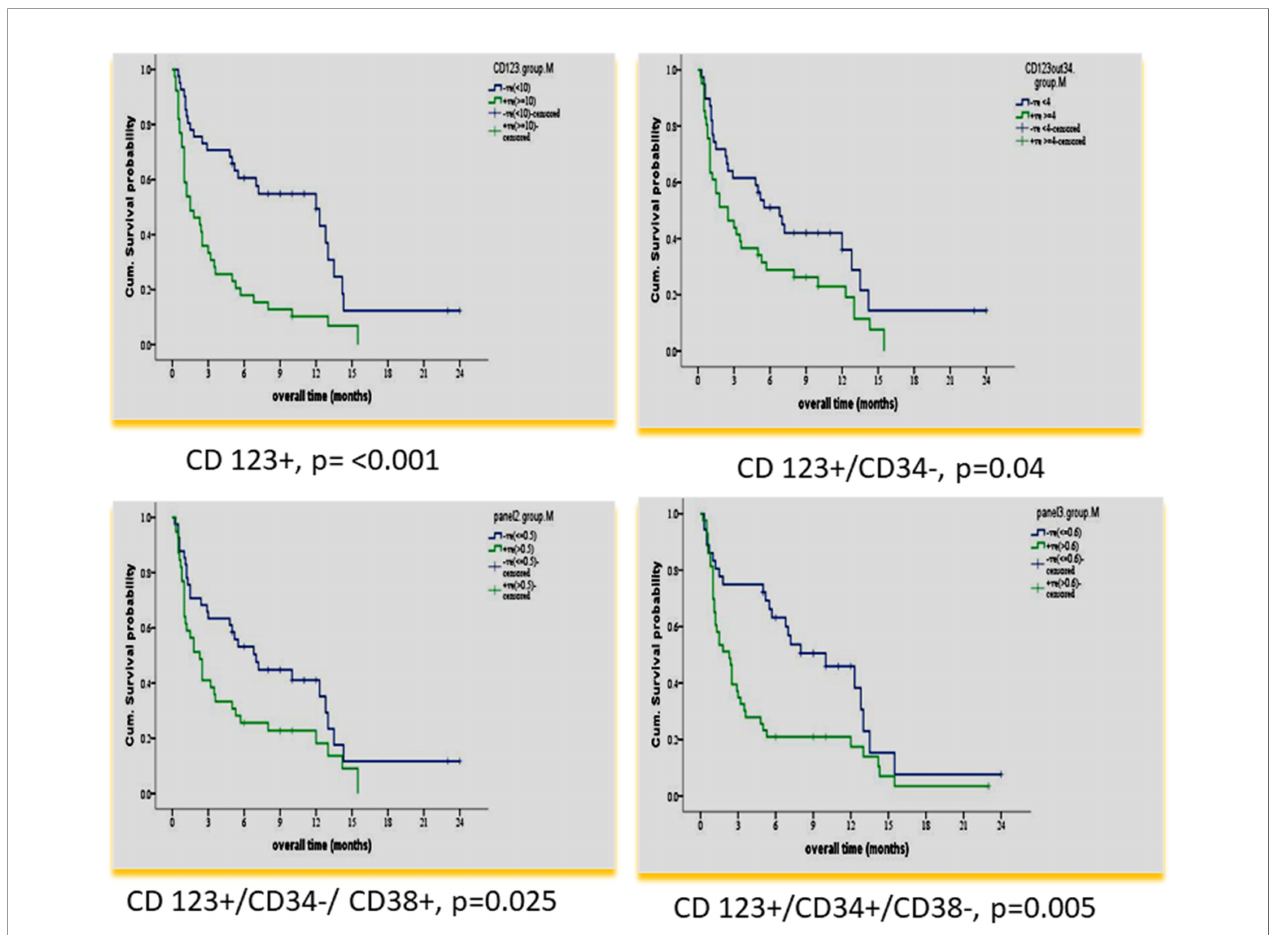
FIGURE 1 | Impact of leukemia stem cell marker(s) at diagnosis on overall survival in 80 adult acute myeloid leukemia patients by using panel CD38 FITC/CD123PE/